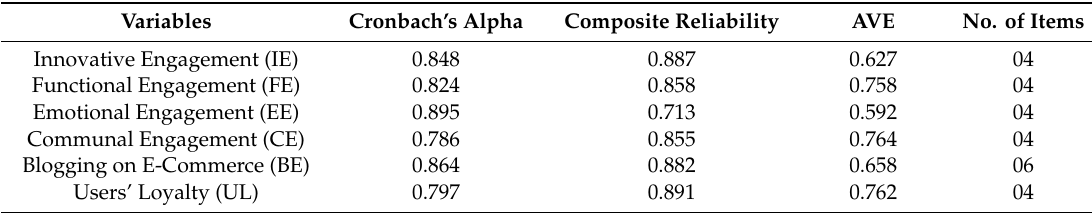
Table 1. Reliability and validity